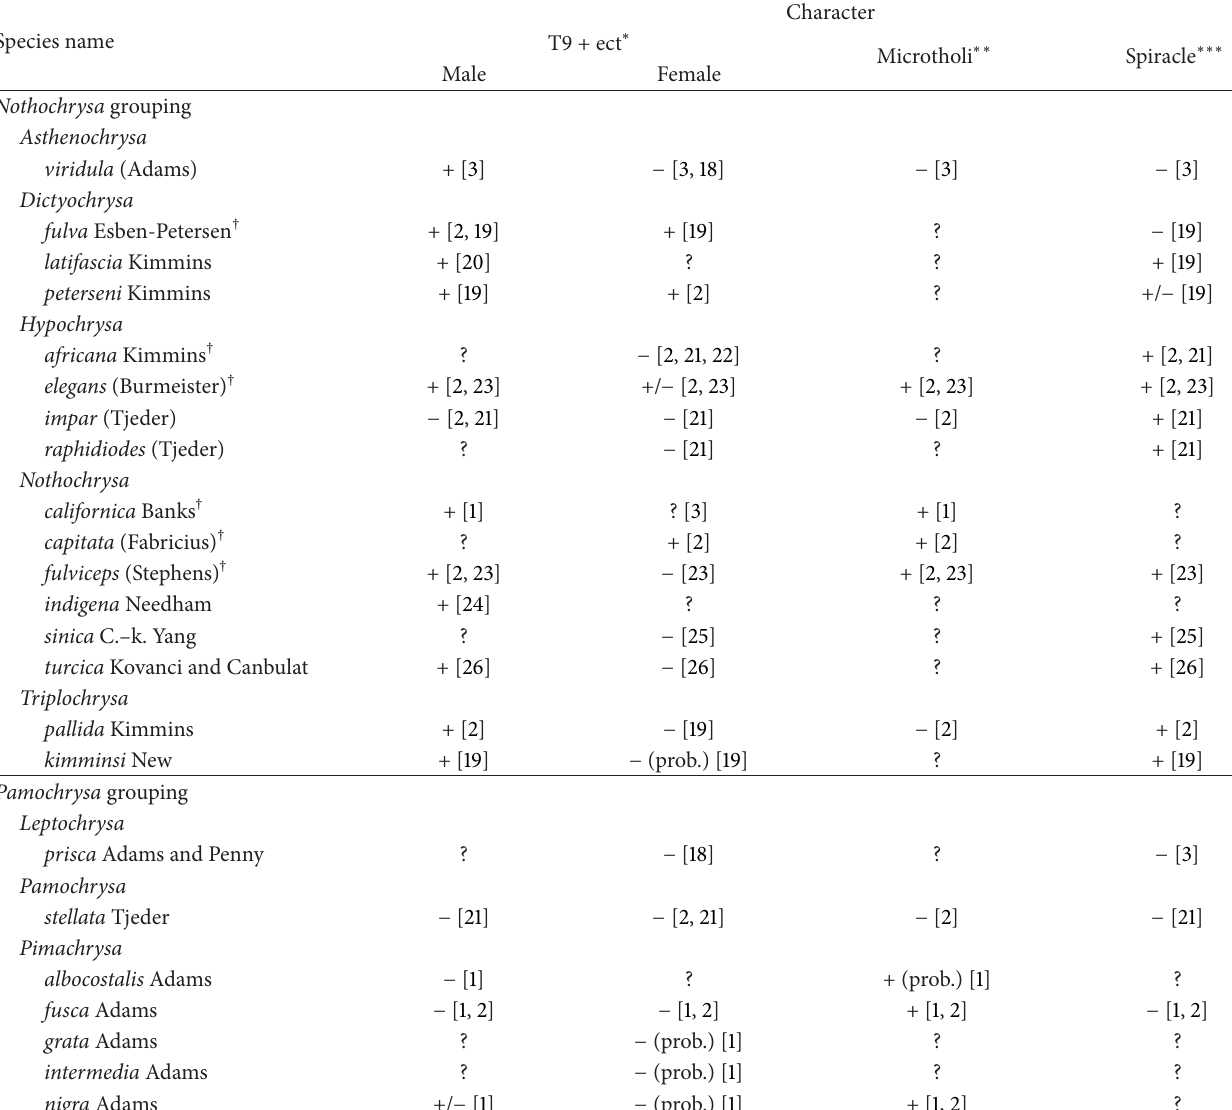
Table 1: Summary of adult characters currently used for classifying Nothochrysinae. All known species are